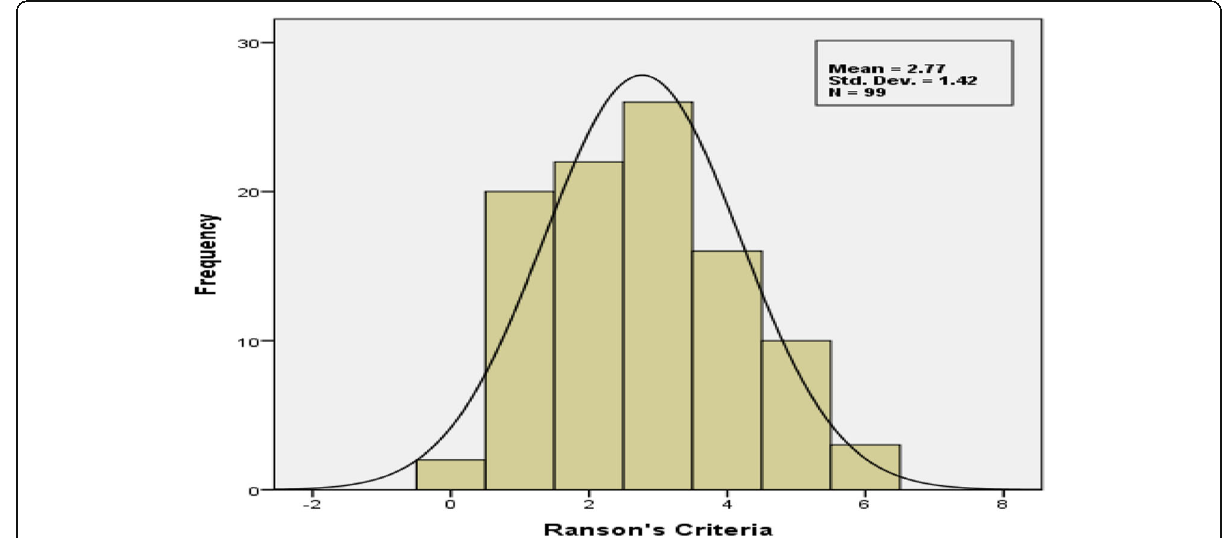
Fig. 5 Distribution of the studied sample according to Ranson ’ s